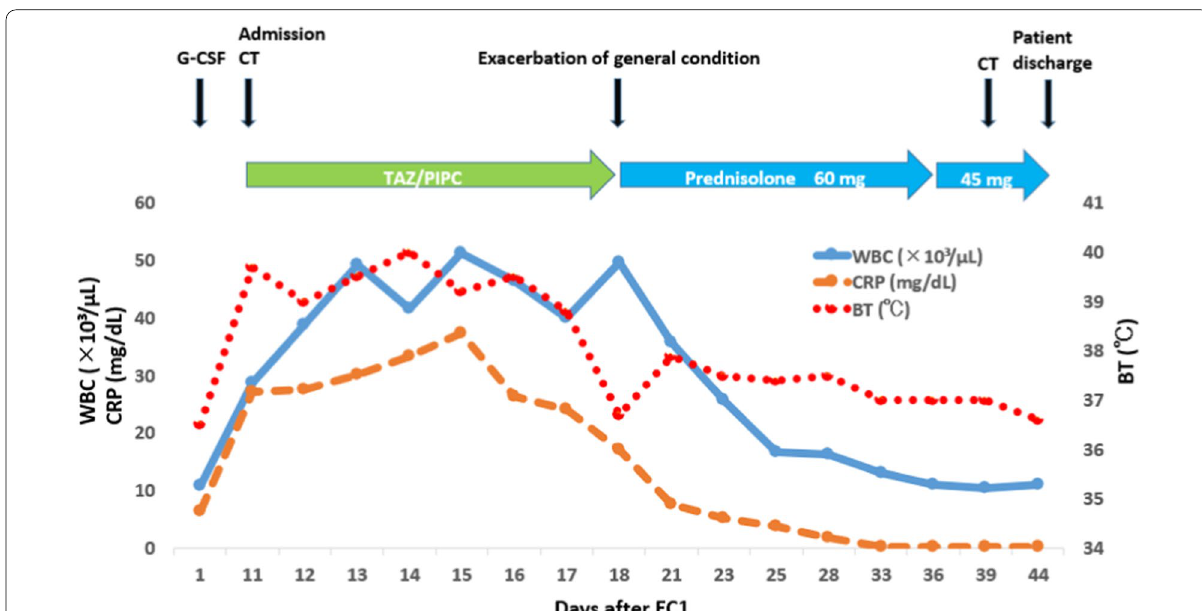
Fig. 2 The clinical course of the case. Pegfilgrastim (PEG-G) is administered on day 3. PEG-G-related aortitis is suspected based on the CT scan on day 11; steroid treatment is initiated on day 18, after which the patient’s general condition and laboratory findings improve dramatically. G-CSF